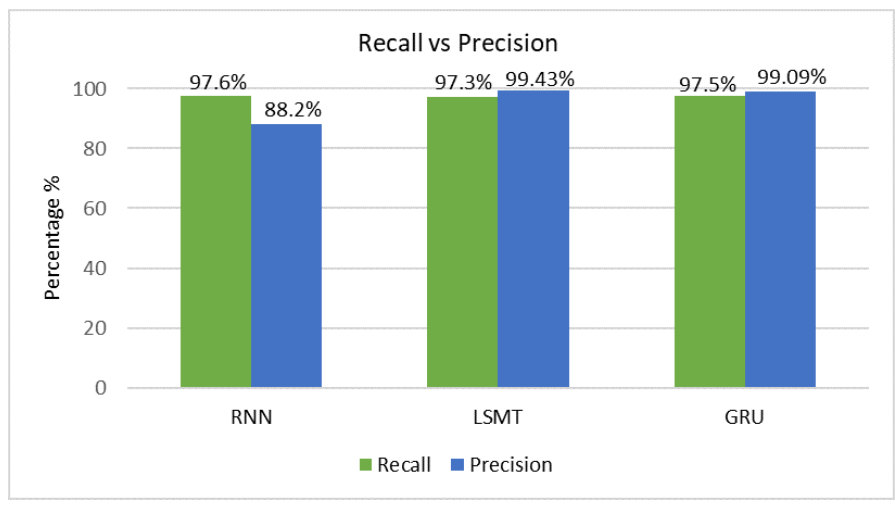
Figure 4. Recall and precision of RNN, LSTM, and GRU.